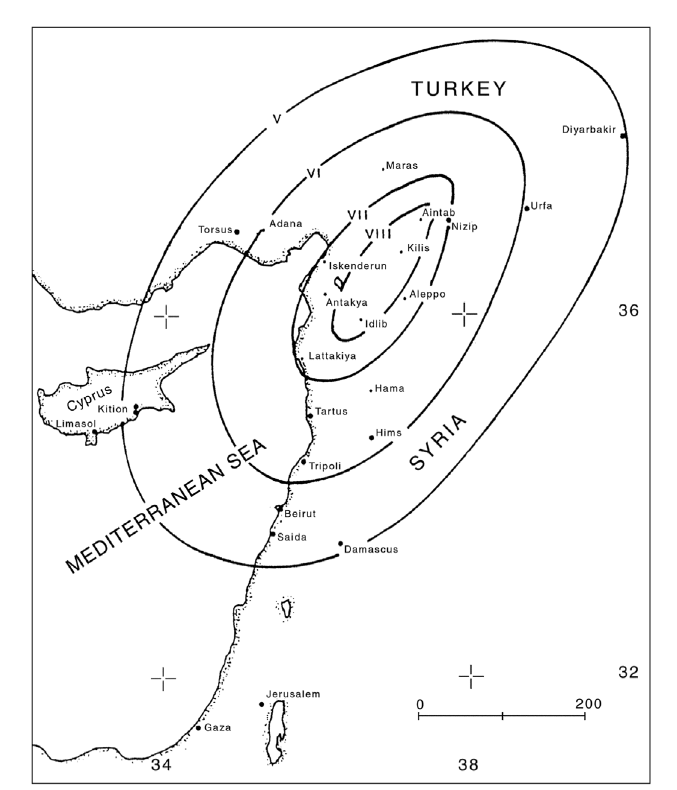
Fig. 12. Map of intensity distribution for August 13, 1822 earthquake (Ambraseys,